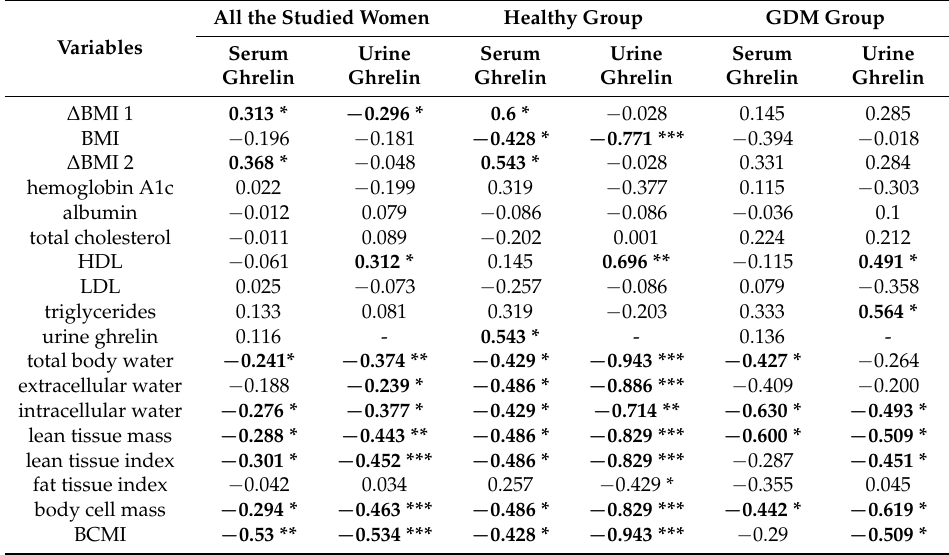
Table 2. Correlations between the maternal serum ghrelin levels and urine ghrelin levels and the selected